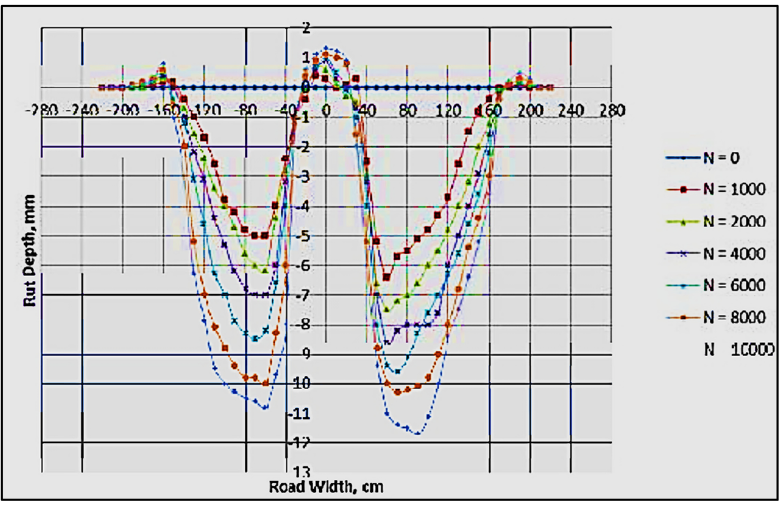
Figure 16: Rutting depth at interfaces I + III.